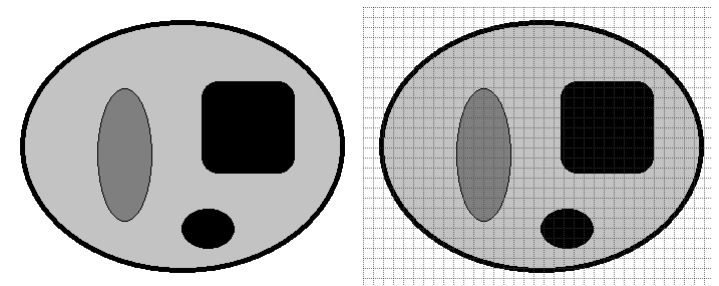
Figure 1. Example of a pixel